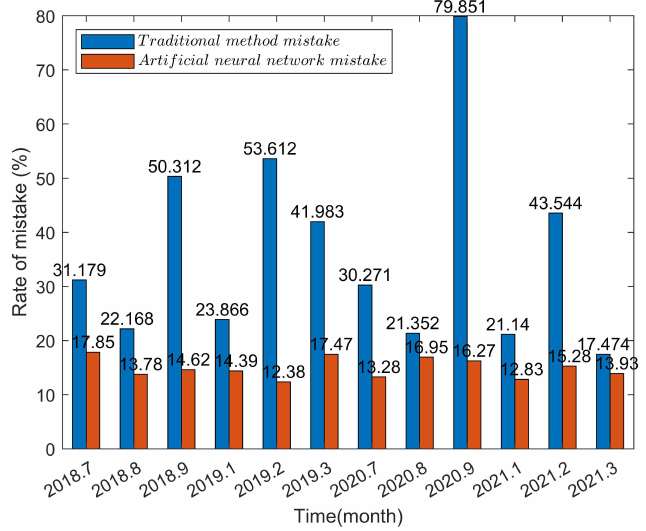
Figure 7. Mistake analysis of prediction